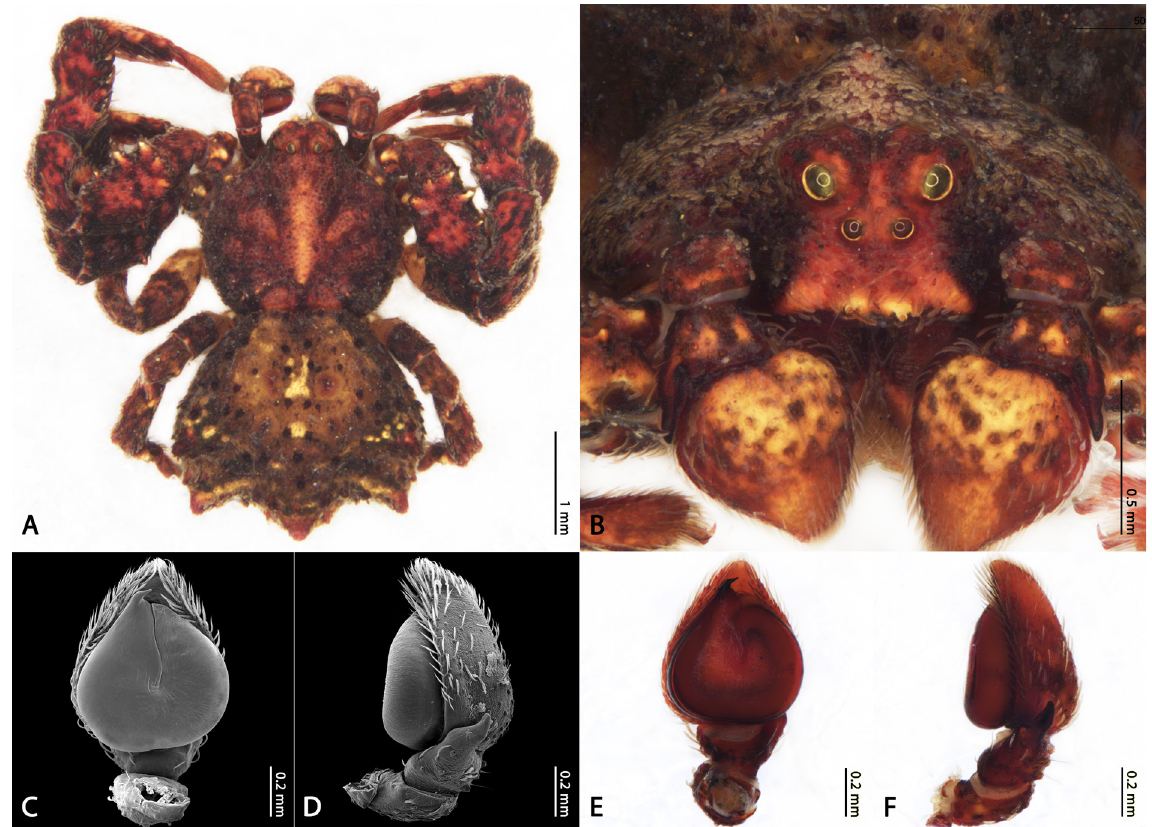
Fig. 17. Male of Kryptochroma septata Machado & Teixeira gen. et sp. nov., paratype (22431). A . Habitus, dorsal view. B . Front. C–F . Left male palp. C, E . Ventral view. D, F . Retrolateral